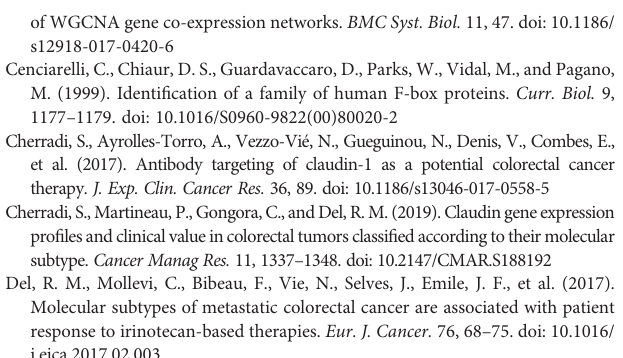
SUPPLEMENTAL FIGURE 1 | Representative fi gures of FBXW4 expression cancerous (A – D) and adjacent cancerous (E – H) colon tissues. SUPPLEMENTAL FIGURE 2 | Representative fi gures of CD3+/4+/8+ expression in cancerous colon tissues. CD3+ expression (A – D) , CD4+ expression (E – H) and CD8+ expression (I – L) . SUPPLEMENTAL FIGURE 3 | Cutoff points for CD3+/4+/8+ expression determined by X-tile program. X-tile analysis divided the entire cohort into the training sets (shown in the upper-left quartile of Figures A , D , and G ) and matched validation sets (shown in the bottom X-axis of Figures A , D , and G ) based on patient survival data. The black dot in the validation set represents the exact cutoff values for the CD3+/4+/8+ expression. The entire cohort was divided into low (blue) and high (gray) CD3+/4+/8+ expression groups based on the optimal cut-off point (CD3 +, 1; CD4+, 1; CD8+, 2);, as shown on a histogram of the entire cohort (B , E , and H) , a Kaplan-Meier curve of overall survival for CD3+ (C), CD4+ (F) , and CD8+ (I) for the optimal cut-off point. SUPPLEMENTAL FIGURE 4 | (A) The immunohistochemical score of FBXW4 in FOLFIRI-resistance and -sensitive cancerous tissue (P = 0.67). (B) The overall survival in mCRC patients with FBXW4 high-expression who received FOLFOX or FOLFIRI chemotherapy (P <